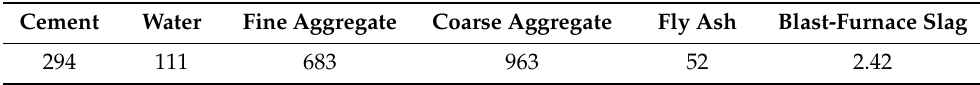
Table 5. Mix design of concrete for base coarse (kg / m 3 ).